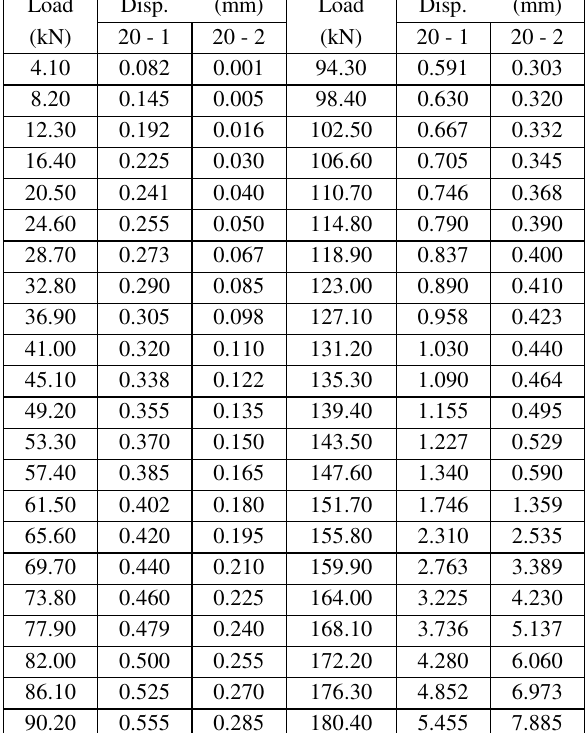
Table 3. Observed Displacements for the 20 mm